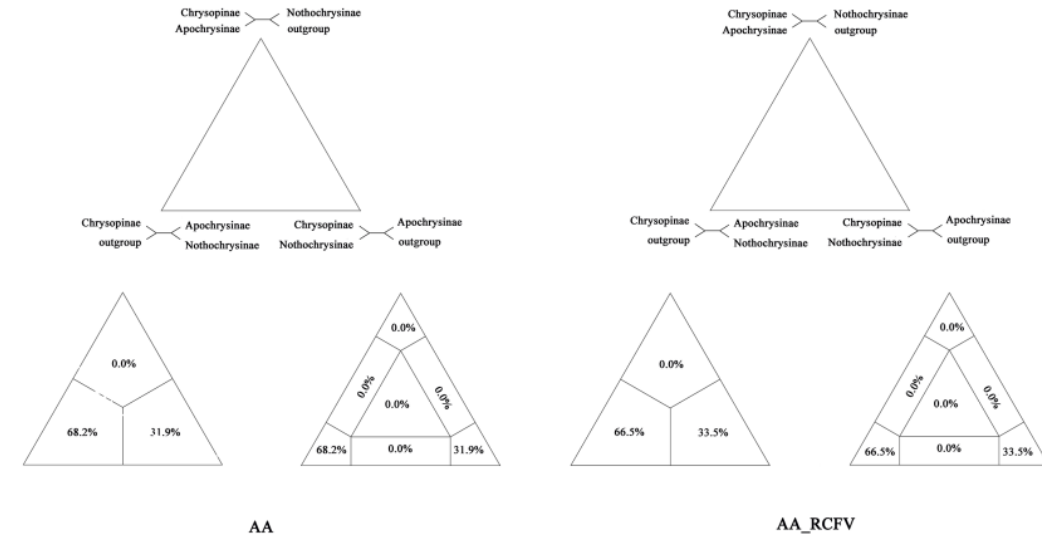
Figure 5. Likelihood mapping results for the amino acids (aa) data matrix, as well as the aa with relative composition frequency variability (RCFV) values smaller than 0.1. AA: amino acids; AA_RCFV: aa with relative composition frequency variability values smaller than 0.1.